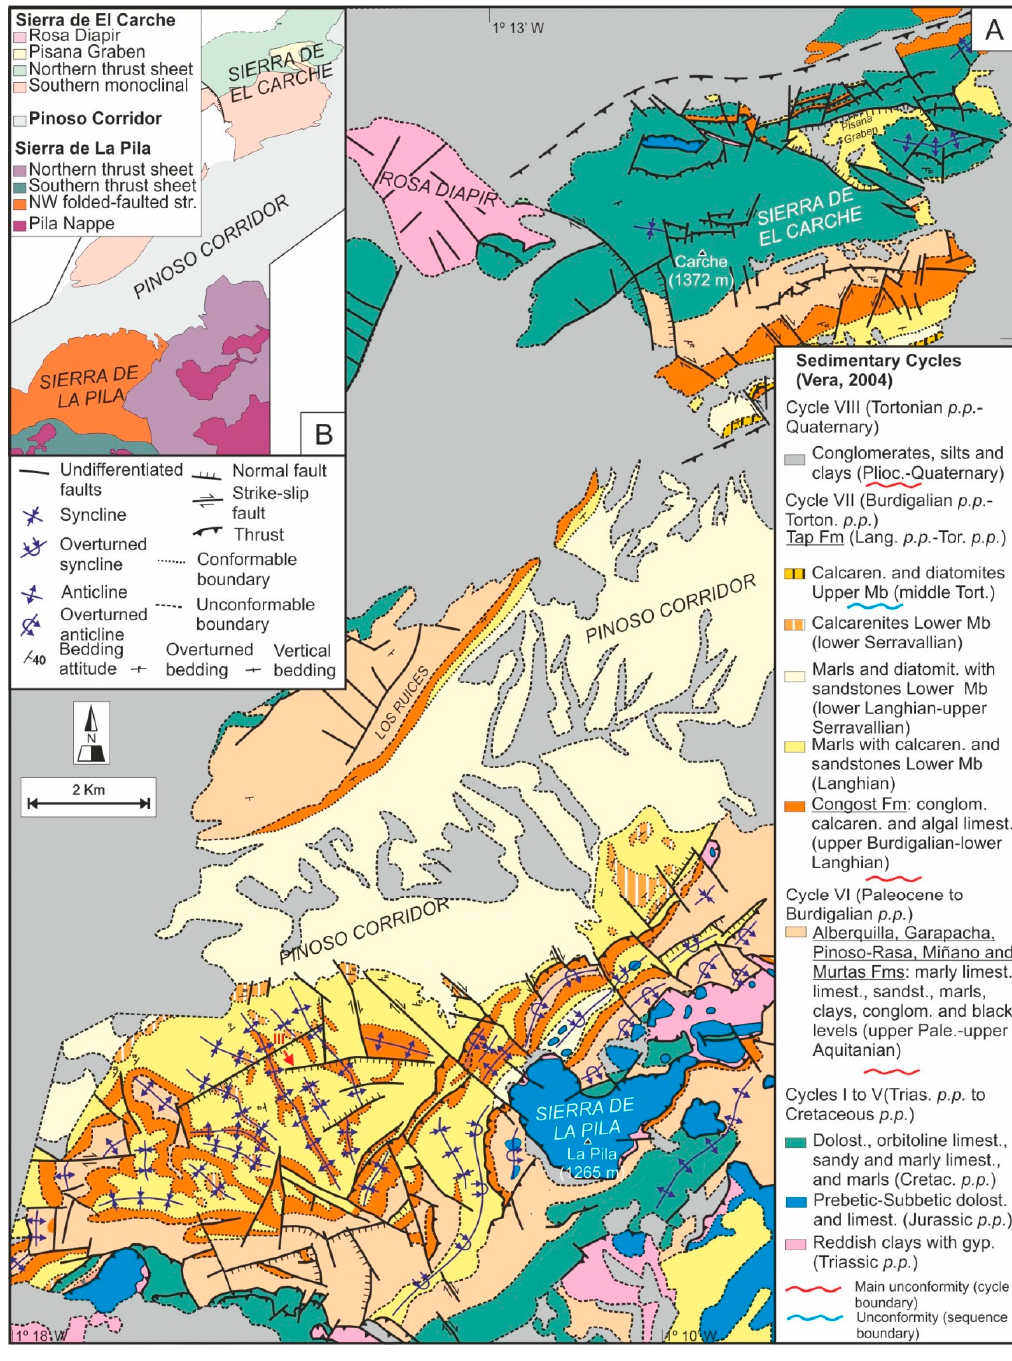
Figure 2. Geological maps of the eastern EBZ in the Murcia sector (after Reference [20]; modified). ( A ) Detailed geological map of the Pila-Carche area. ( B ) Structural sketch map of the Pila-Carche area.